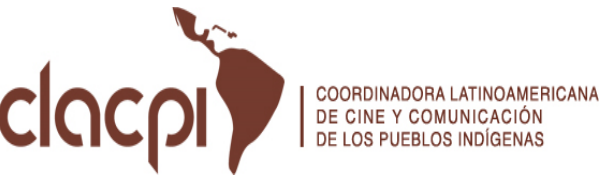
Figure 1. Indigenous Peoples Latin American Cinematography and Communication